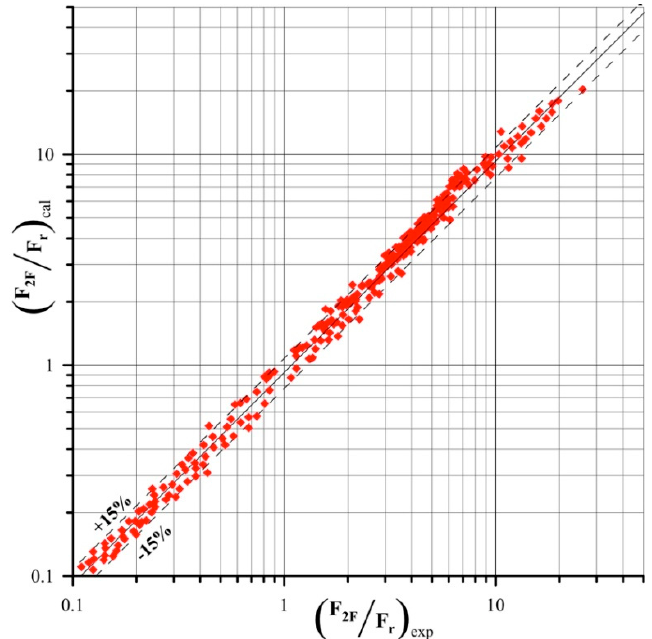
Figure 20. Comparison of variations in the relative value of interfacial surface in relation to internal surface area of the pipe, measured and calculated on the basis of (22).